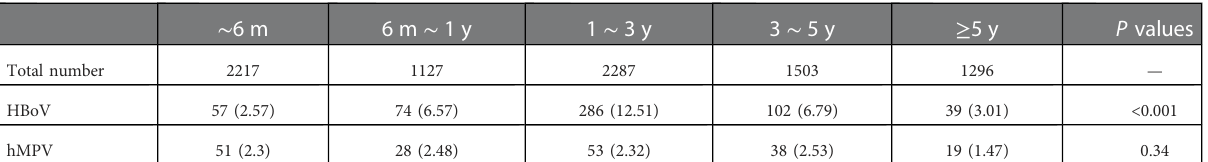
TABLE 1 Detection of HBoV and hMPV in different age groups [ n (%)].